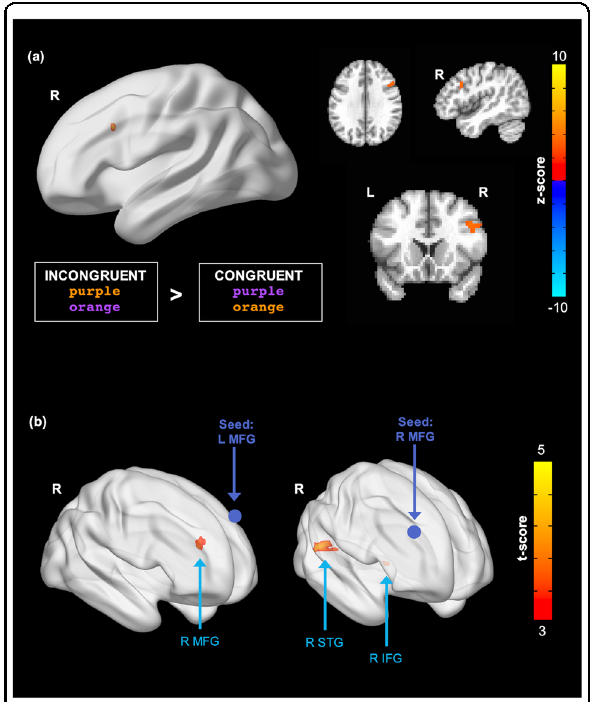
Fig. 3 Exploratory whole-brain analysis of changes in task-based activation and resting-state functional connectivity (rsFC) following 4 weeks of the intervention. a Greater activation at post- EVO in the right middle frontal gyrus (MFG) during the Stroop/Flanker task for incongruent trials relative to congruent trials; voxel threshold: p < 0.005, cluster threshold: p < 0.07. b Increased functional connectivity from pre- to post-EVO from the left MFG seed to the right MFG and the right MFG seed to the right superior temporal gyrus (STG) and right inferior frontal gyrus (IFG); voxel threshold: p < 0.001, cluster threshold: p <